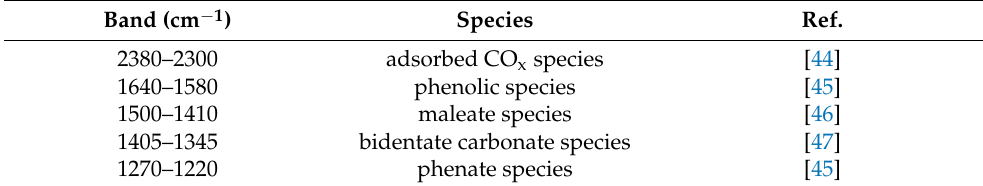
Table 3. The adsorption bands and corresponding species.